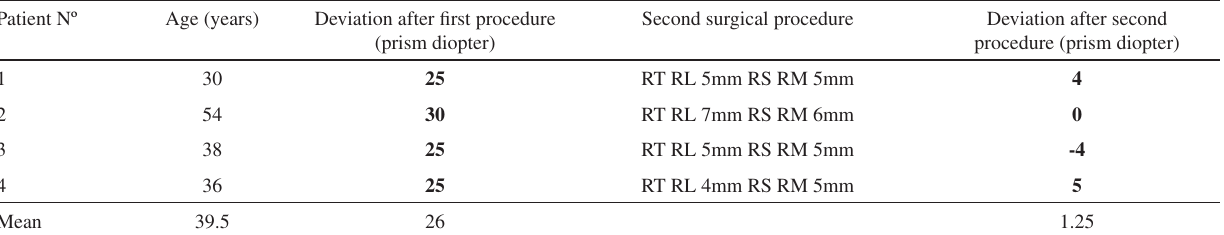
Table 4 - Group 2 patients (exotropia) who underwent a second procedure Patient Nº Age (years) Deviation after first procedure Second surgical procedure Deviation after second (prism diopter) procedure (prism